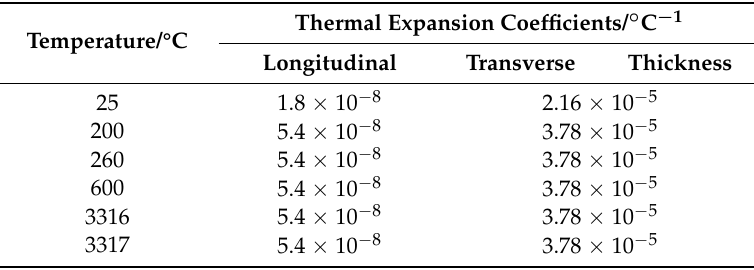
Table 3. Thermal expansion coefficients of IM600/133 composite material.